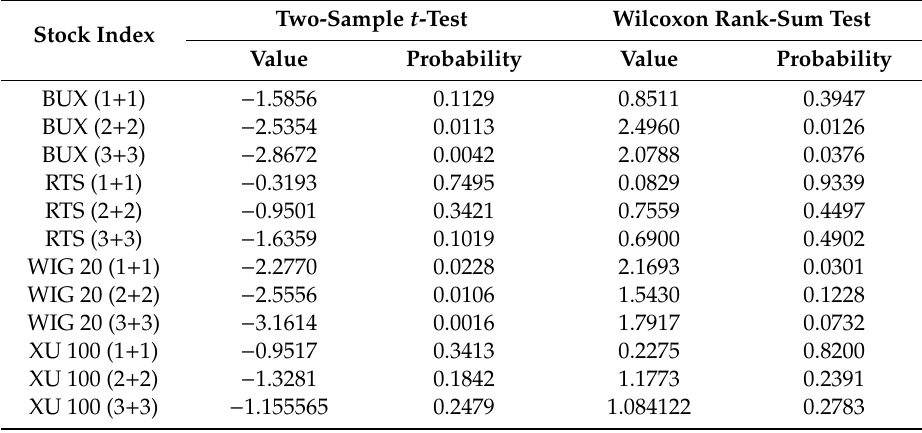
Table 6. Results of the statistical significance tests—Daily volatilities (alternative